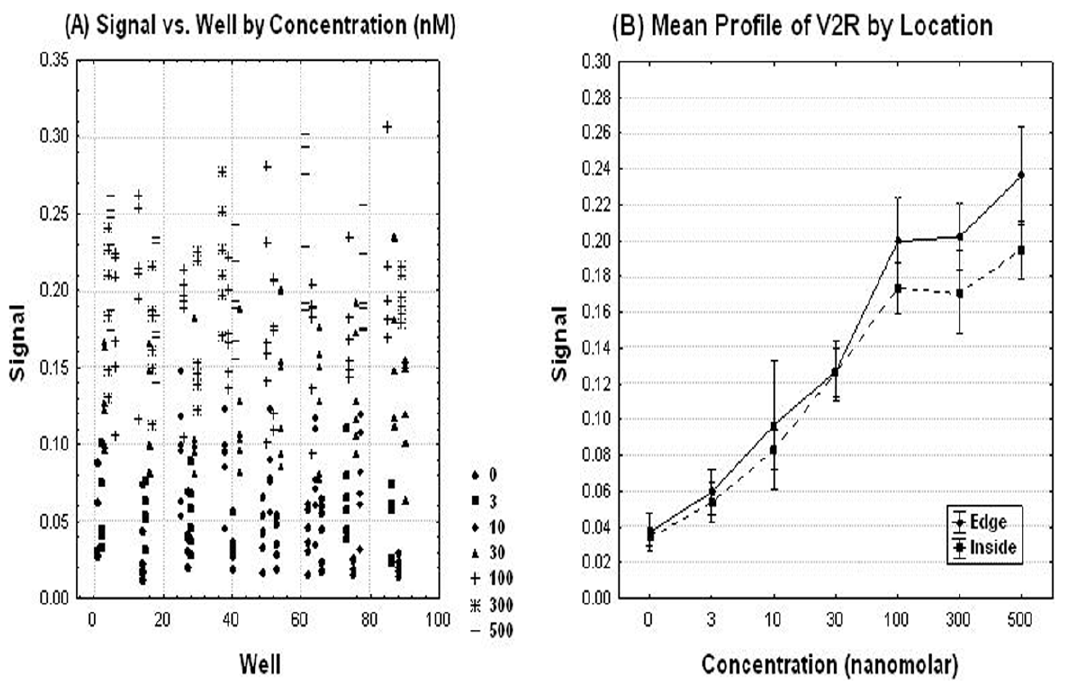
Figure 7. Spatial uniformity assessment for the V2R pharmacoperone assay. The signal was plotted against well number, where the wells are ordered by row first then by column in order to explore any pattern of edge, drift effect and other systematic source of variability.